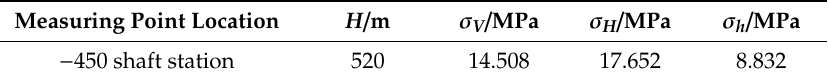
Figure 2. Arrangement of ground stress measuring points in the no.2 mining area. Table 1. Ground stress value of no.2 mining area.